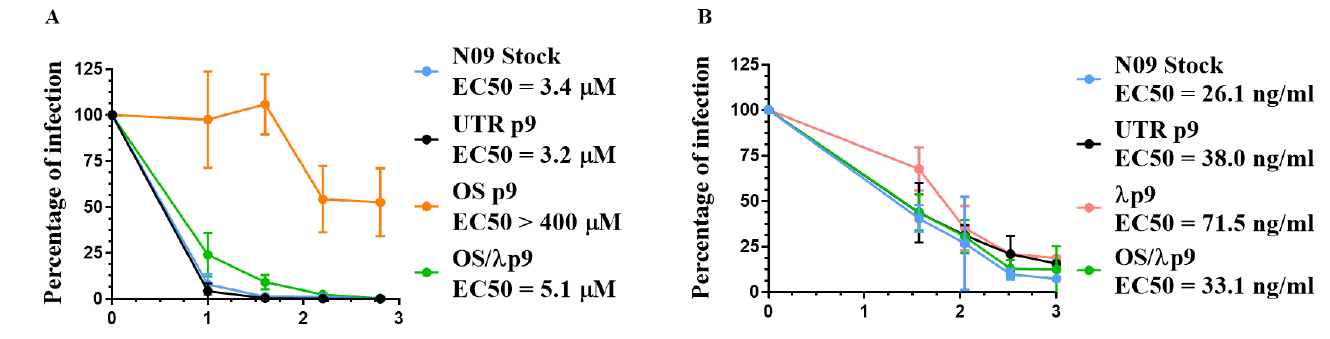
Figure 4. Antiviral effect of OS ( A ) and IFN λ 1 ( B ) against the A(H1N1)pdm09 variants grown for nine passages in Calu-3 cells and measured by a virus yield reduction assay in MDCK cells. Mean EC50 values and standard deviations were calculated from two independent experiments performed in duplicate. OS p9 = virus passaged nine times in the presence of OS alone; λ p9 = virus passaged nine times in the presence of IFN λ 1 alone; OS/ λ p9 = virus passaged nine times in the presence of OS plus IFN λ1; UTR p9 = virus passaged nine times in the absence of selective drug pressure; N09 Stock = virus produced in MDCK cells and never passaged in Calu-3.